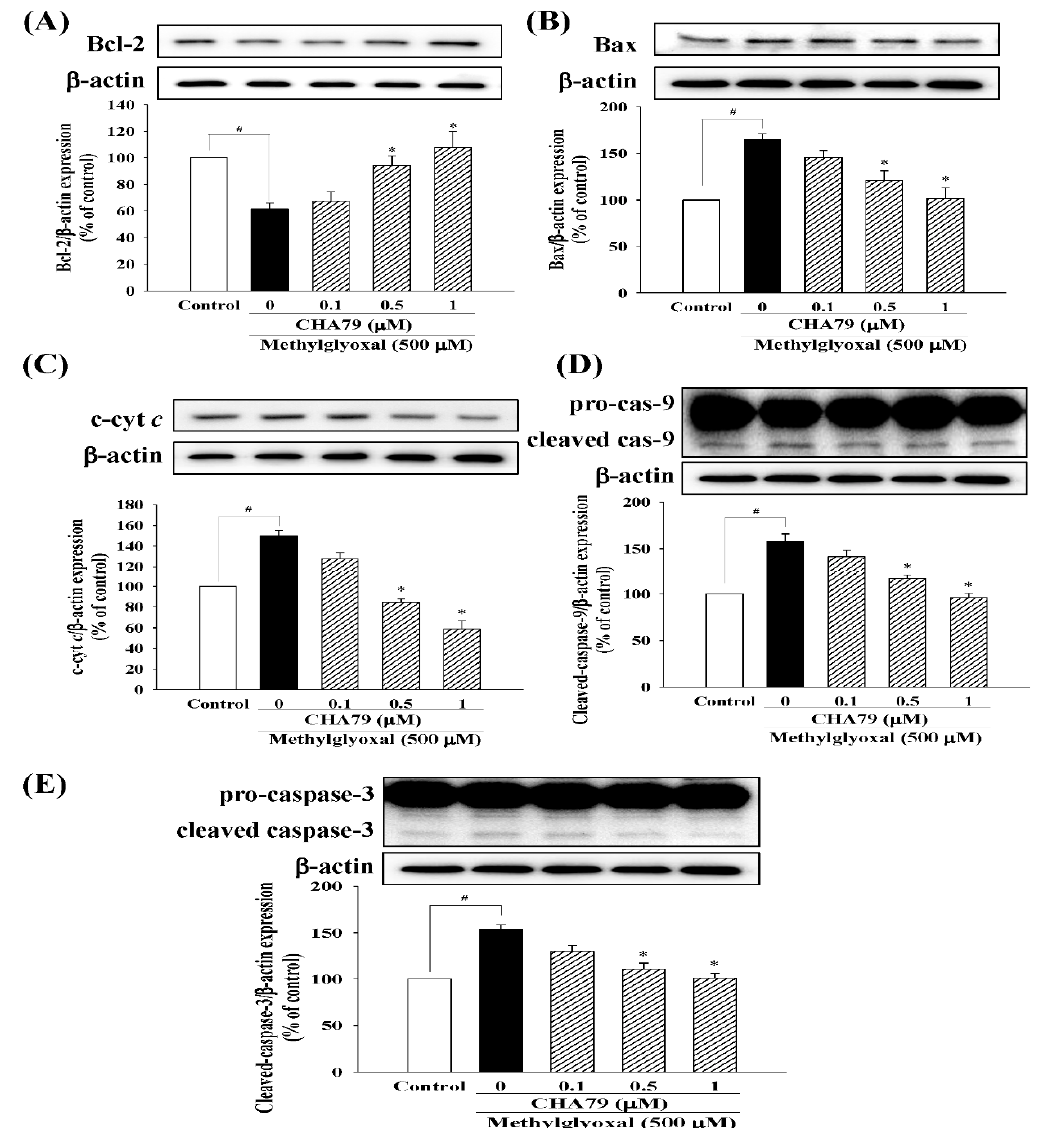
Figure 3. Effects of CHA79 on expressions of Bcl-2 ( A ), Bax ( B ), cytosolic cytochrome c (c-cyt c ) ( C ), cleaved caspase-9 ( D ), and cleaved caspase-3 ( E ) in MG-treated SH-SY5Y dopaminergic neurons. Cells were pre-treated with CHA79 (0.1–1 µ M) for 1 h, and MG (500 µ M) was then treated for 24 h. Densitometry analyses are presented as the relative ratio of protein / β -actin protein, and are represented as percentages of control group (vehicle control: 0.1% DMSO). Bars represent the mean ± SEM ( n = 6). # p < 0.05 versus the control group (vehicle control: 0.1% DMSO). * p < 0.05 versus the MG group.